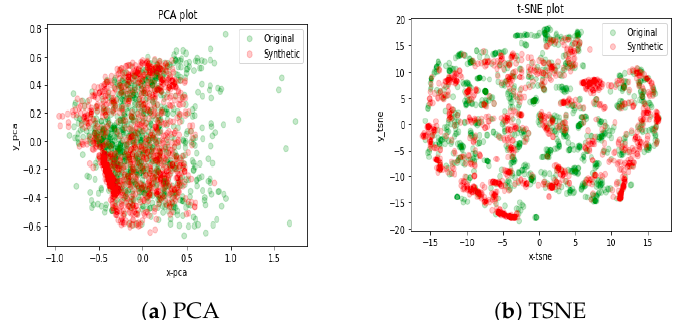
Figure 6. Proposed Model—RMSProp (lr = 0.001, momentum = 0.01, decay rate = 0.9).